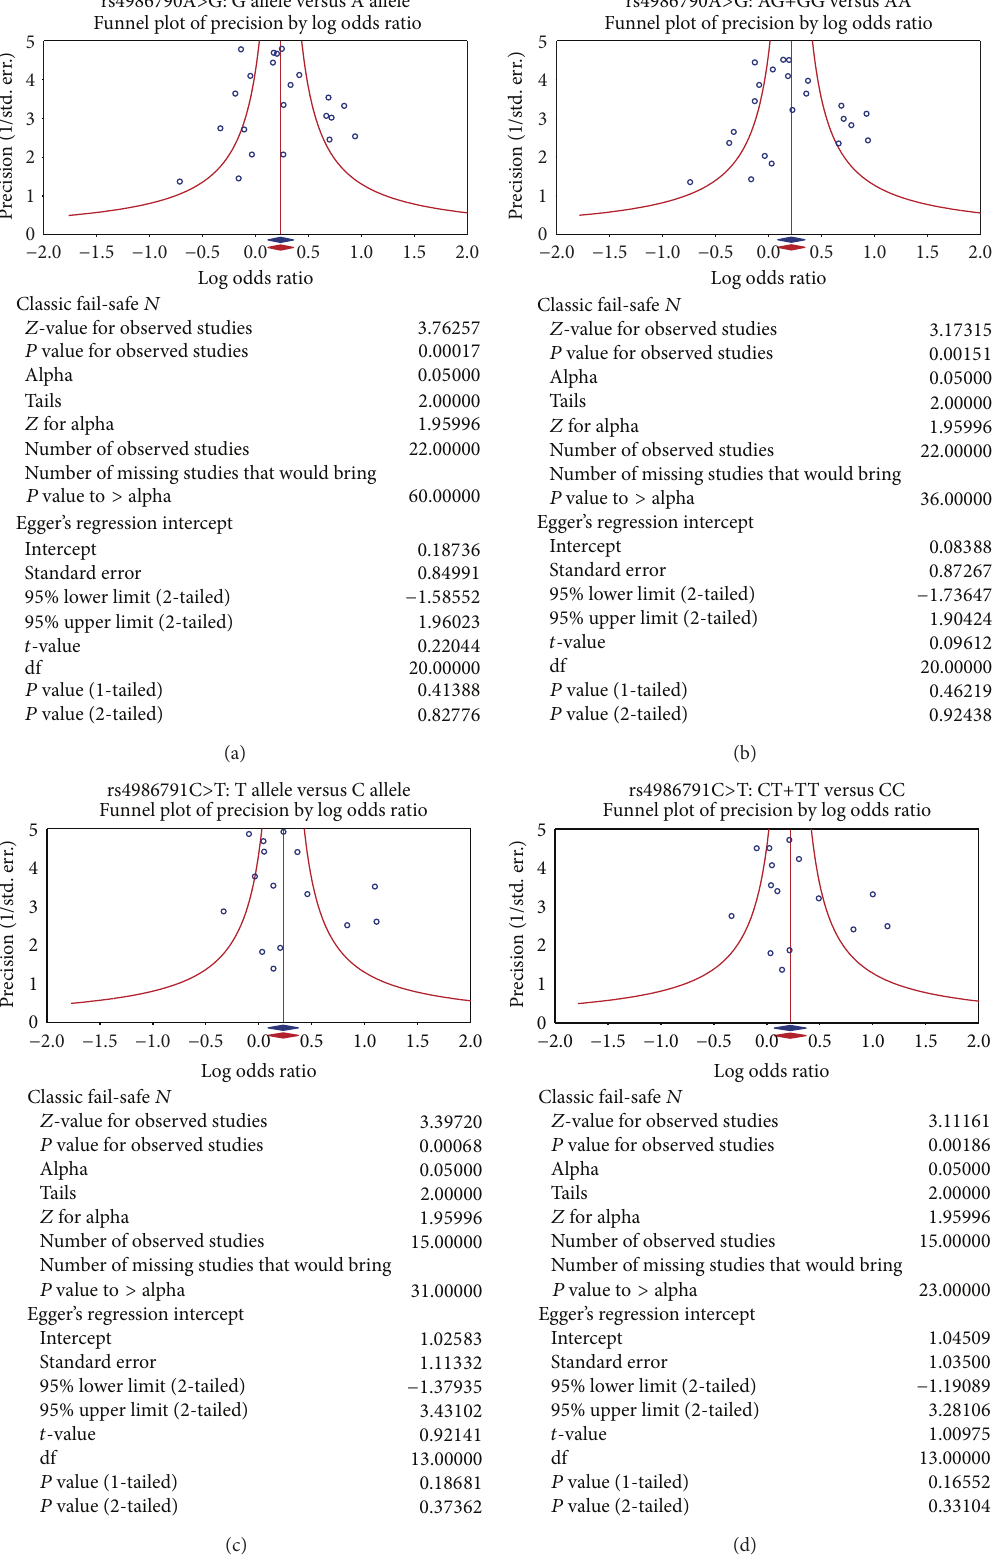
Figure 6: Publication bias of the differences in allele and genotype frequencies of TLR4 rs4986790A > G and rs4986791C > T polymorphism between case and control groups. (a) Publication bias of the differences in allele frequencies of rs4986790A > G; (b) publication bias of the differences in genotype frequencies of rs4986790A > G; (c) publication bias of the differences in allele frequencies of rs4986791C > T; (d) publication bias of the differences in genotype frequencies of rs4986791C >